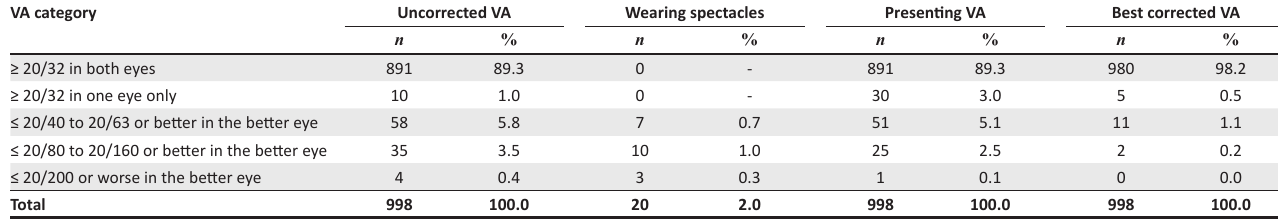
TABLE 1: Distribution of uncorrected, presenting and best corrected visual acuity. VA category